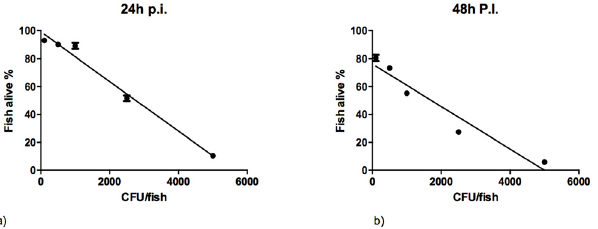
Fig 3. LD 50 determination. Zebrafish larvae were injected with 100, 500, 1000, 2500 and 5000 colony forming units. a. Survival rate of infected larvae at 24 hpi. b. Survival rate of infected larvae at 48 hpi. At both time points, results were obtained in 3 independent experiments, and 25 larvae were injected per